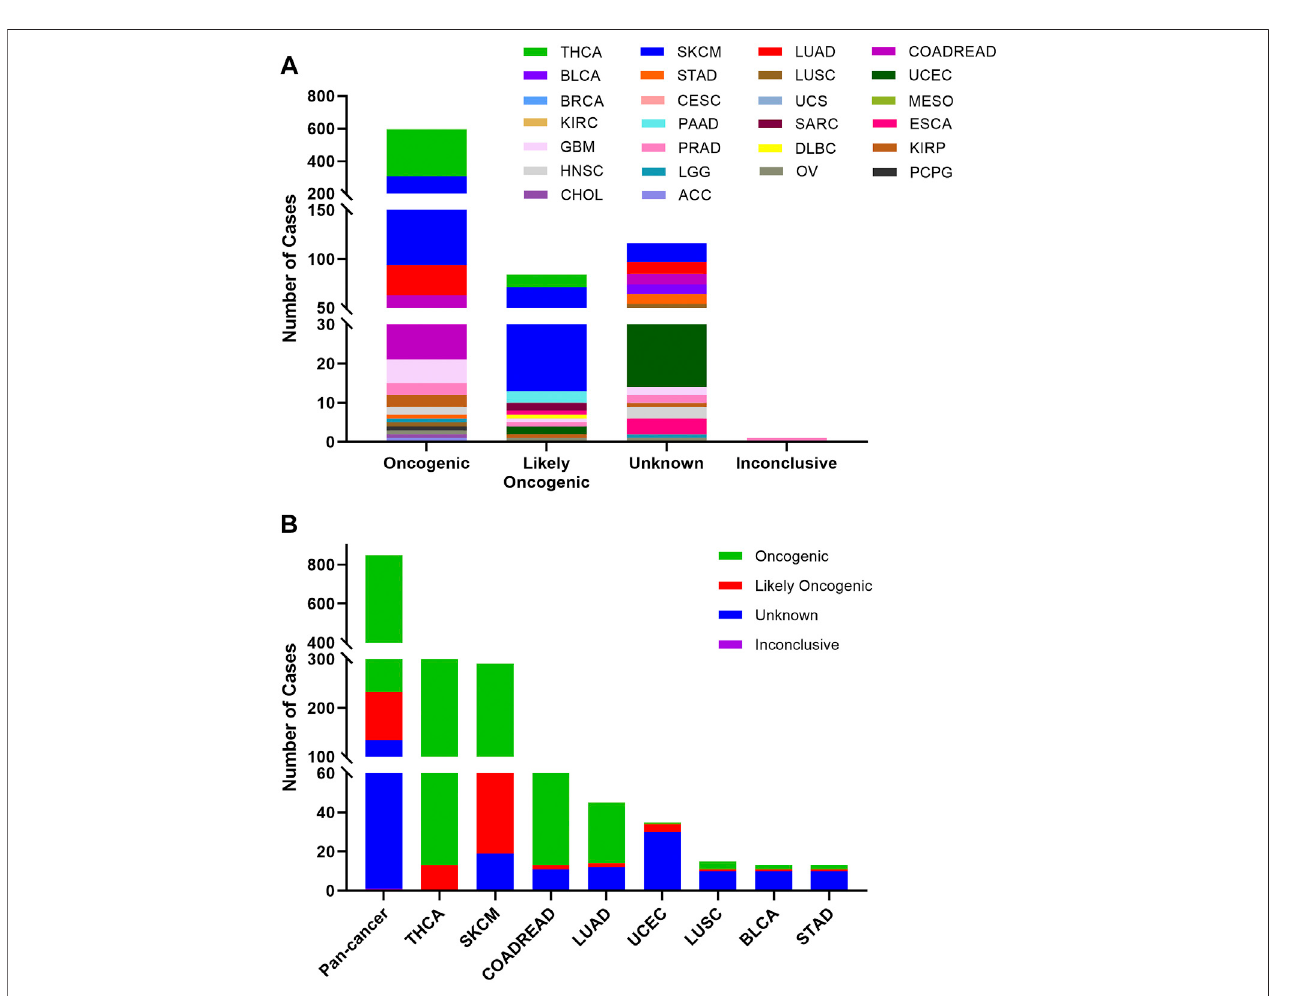
FIGURE 4 | BRAF mutation classi fi cation by functional impacts. (A) BRAF mutations based on functional impacts on all tumors together. (B) Functional impact class distribution of BRAF mutations in pan-cancer and the top 8 cancer types.